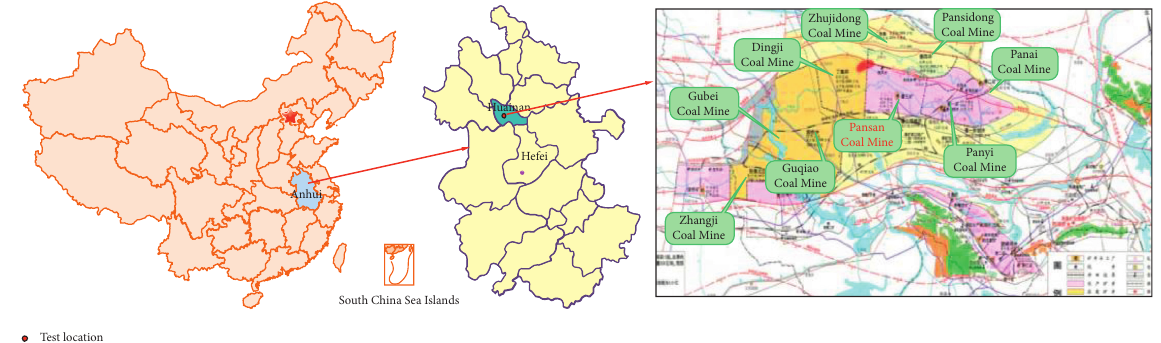
Figure 1: Geographical location of the study area and locations of the engineering test sites [17].